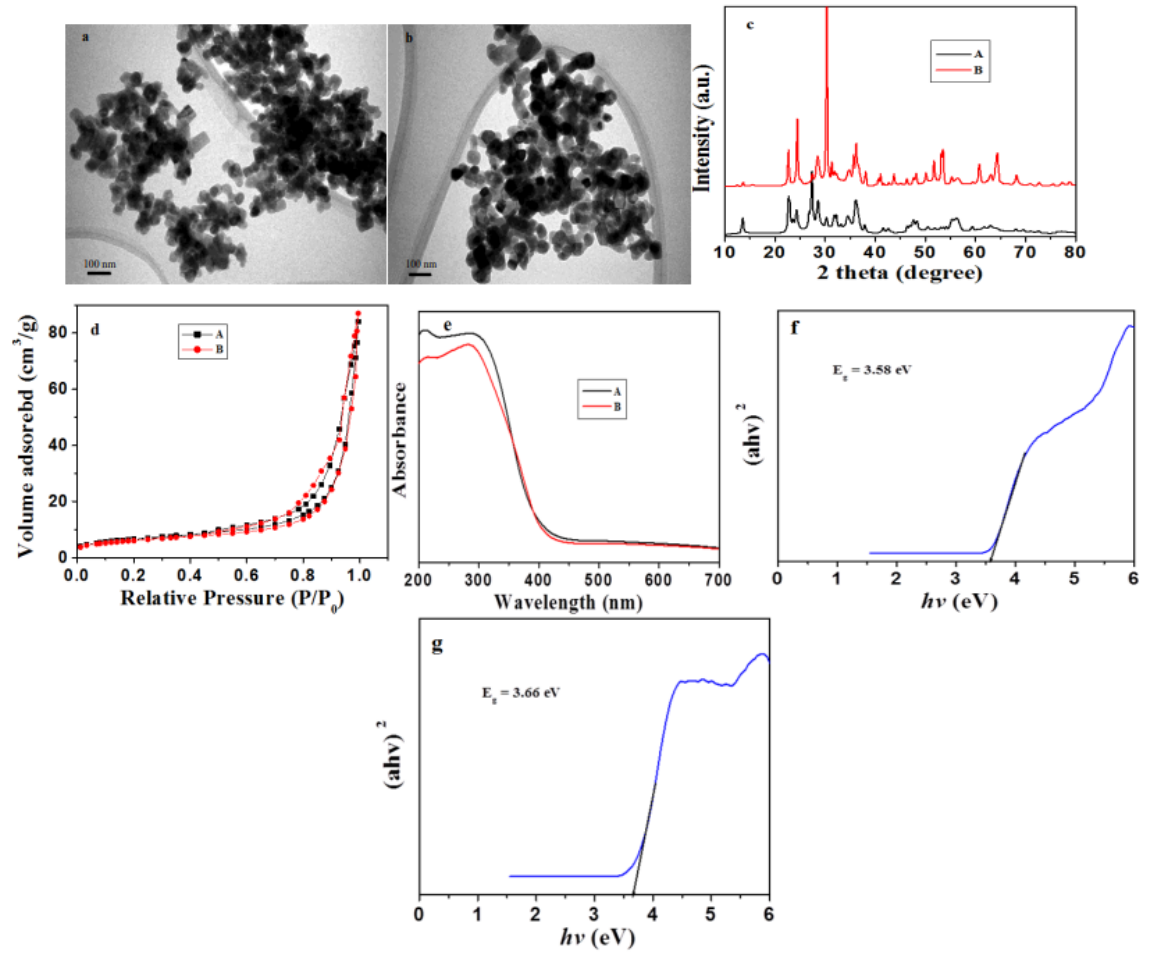
Figure 1. Physical characterization of the β -Nb 2ZnO6 nanoparticles. TEM images of β -Nb2ZnO6 nanoparticles calcined at 500 °C ( A ) and 700 °C ( B ) ( a ) and ( b ), XRD pattern of β -Nb2ZnO6 ( A and B ) ( c ), N2 adsorption- desorption isotherm of β -Nb2ZnO6 ( A and B ) ( d ), UV-Vis spectra of β -Nb2ZnO6 ( A and B ) ( e ), Tauc plots of β -Nb2ZnO6 ( A and B ) ( f , g ).